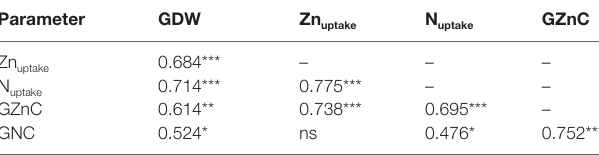
TABLE 2 | Correlative coefficients (r) among grain dry weight (GDW), post- anthesis Zn uptake (Zn uptake ), post-anthesis N uptake (N uptake ), grain Zn concentration (GZnC), and grain N concentration (GNC) in 2009 and in 2010 ( n = 21). Parameter GDW Zn uptake N uptake